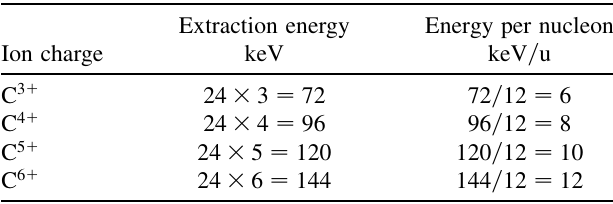
TABLE XI. Ion source energies at